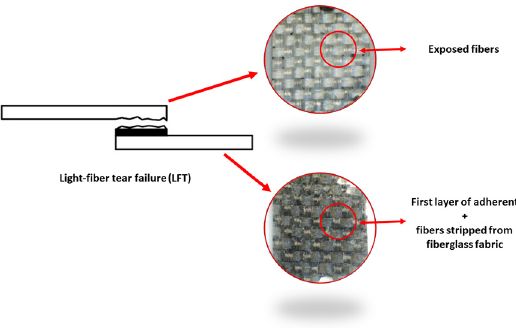
Figure 2. Diagram of a light-fiber tear